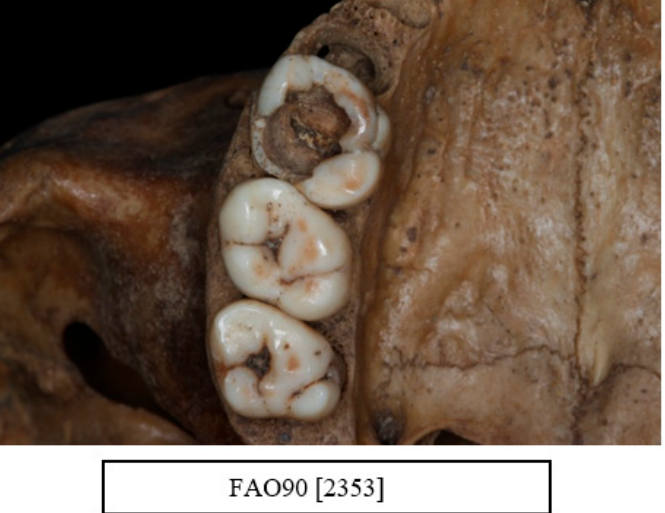
Figure 6. Occlusal view showing an extensive carious lesion in the upper right first molar (UR6) extending to the pulp chamber (courtesy of the Museum of London).